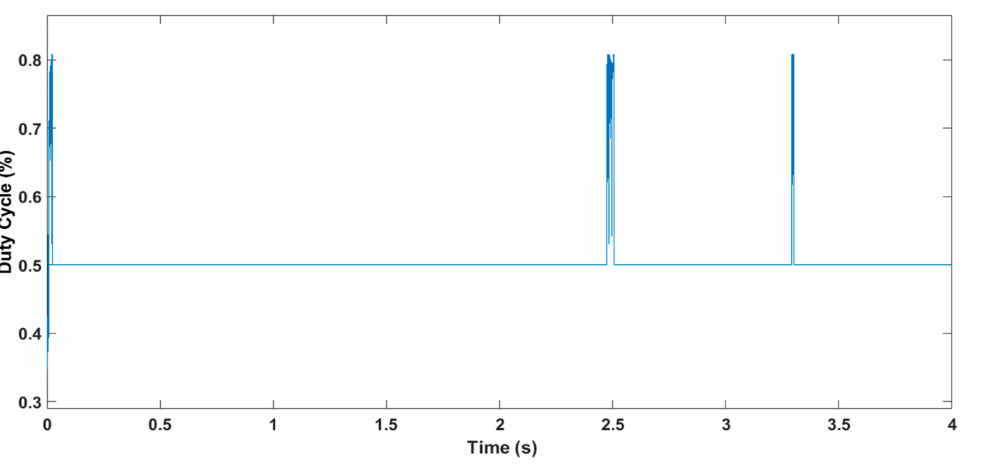
Figure 24. The response of FLC during braking.